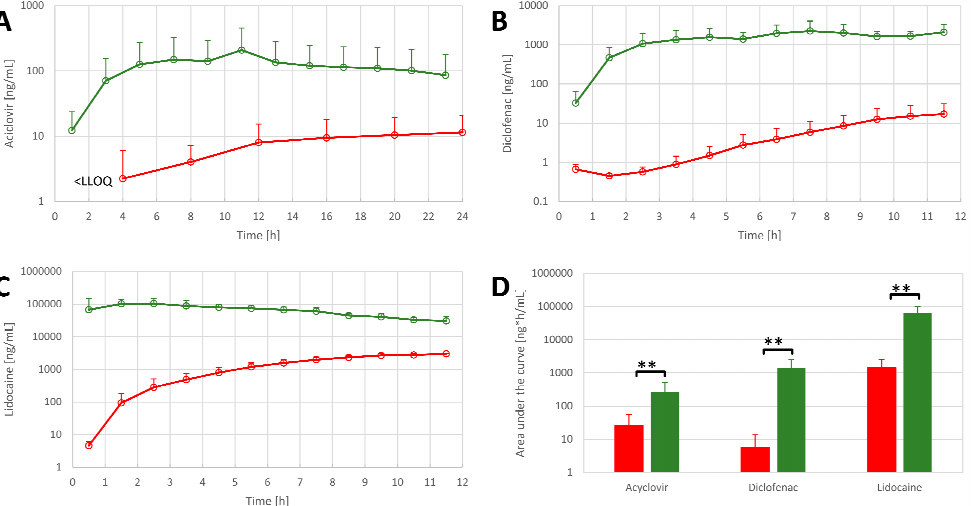
Figure 6. API concentrations in OFM samples from FTSE (n = 3, green) and skin explants (n = 4, red) for ( A ) acyclovir, ( B ) diclofenac, and ( C ) lidocaine. ( D ) Comparison of the total concentration of APIs in OFM samples in FTSE (green bars) and skin explants (red bars). Data are shown as the mean and SD (only upward error bars are shown for readability). ** p ≤